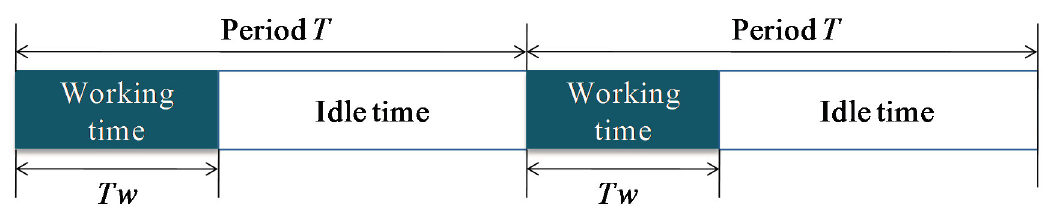
Figure 21. Node works intermittently. During the working time, the WSN tasks will be performed. If the traditional single-core node (node which is equipped with only the working microcontroller) is used, the node needs to fall asleep when it is idle, and the energy cost within one period is: